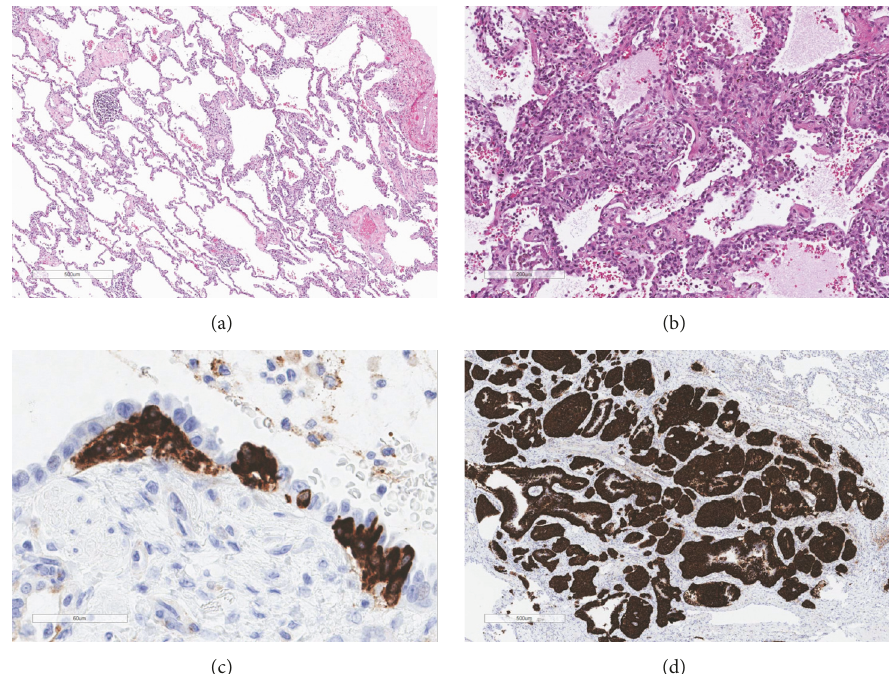
Figure 3: (a) Hematoxylin and eosin (H&E) stain 4x showed chronic interstitial pneumonia, overall pattern most consistently with NSIP. (b) H&E stain 10x showed alveolar septal thickening. (c) Synaptophysin 4x showed PNEC hyperplasia. (d) Synaptophysin 10x showed a carcinoid tumorlet sized approximately 2.5–3